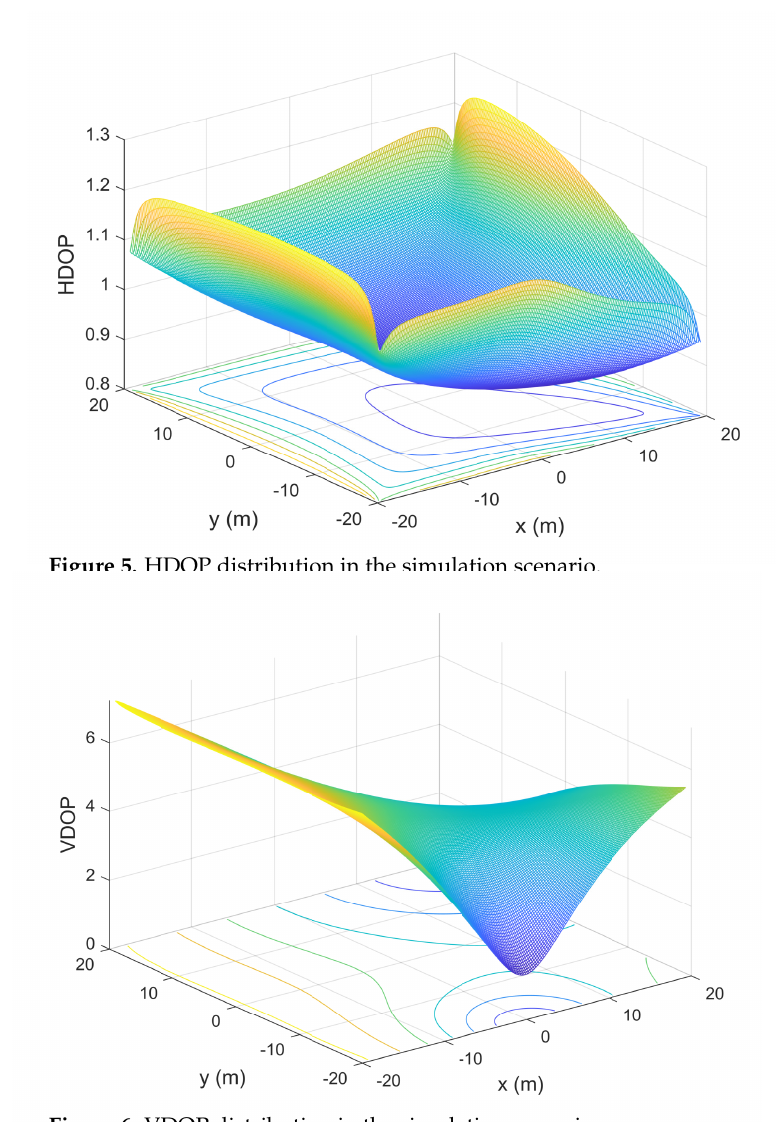
Figure 6. VDOP distribution in the simulation